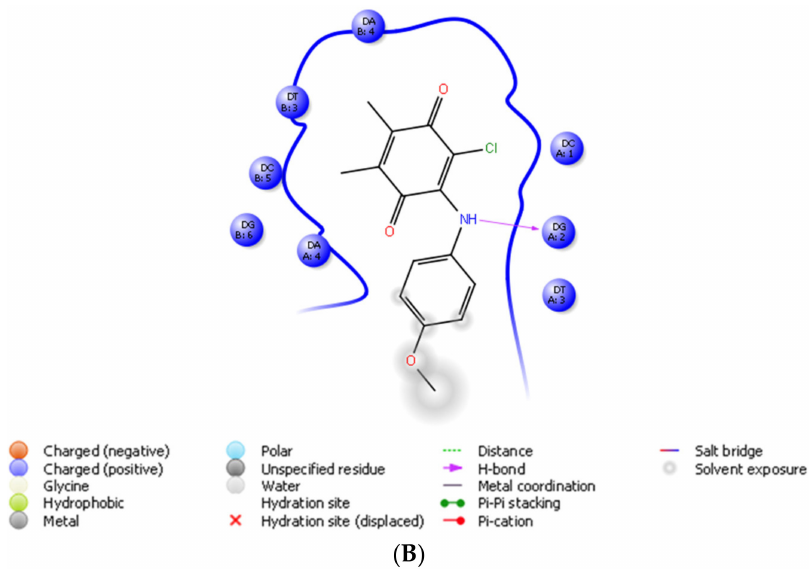
Figure 8. ( A ) Docking poses of ABQ-3 , ABQ-11 , and ABQ-12 and ( B ) docking interactions of ABQ-3 in the minor groove of DNA (PDB ID: 2GB9) ( ABQ-3 , ABQ-11 , and ABQ-12 are colored in orange, plum, and turquoise, respectively).